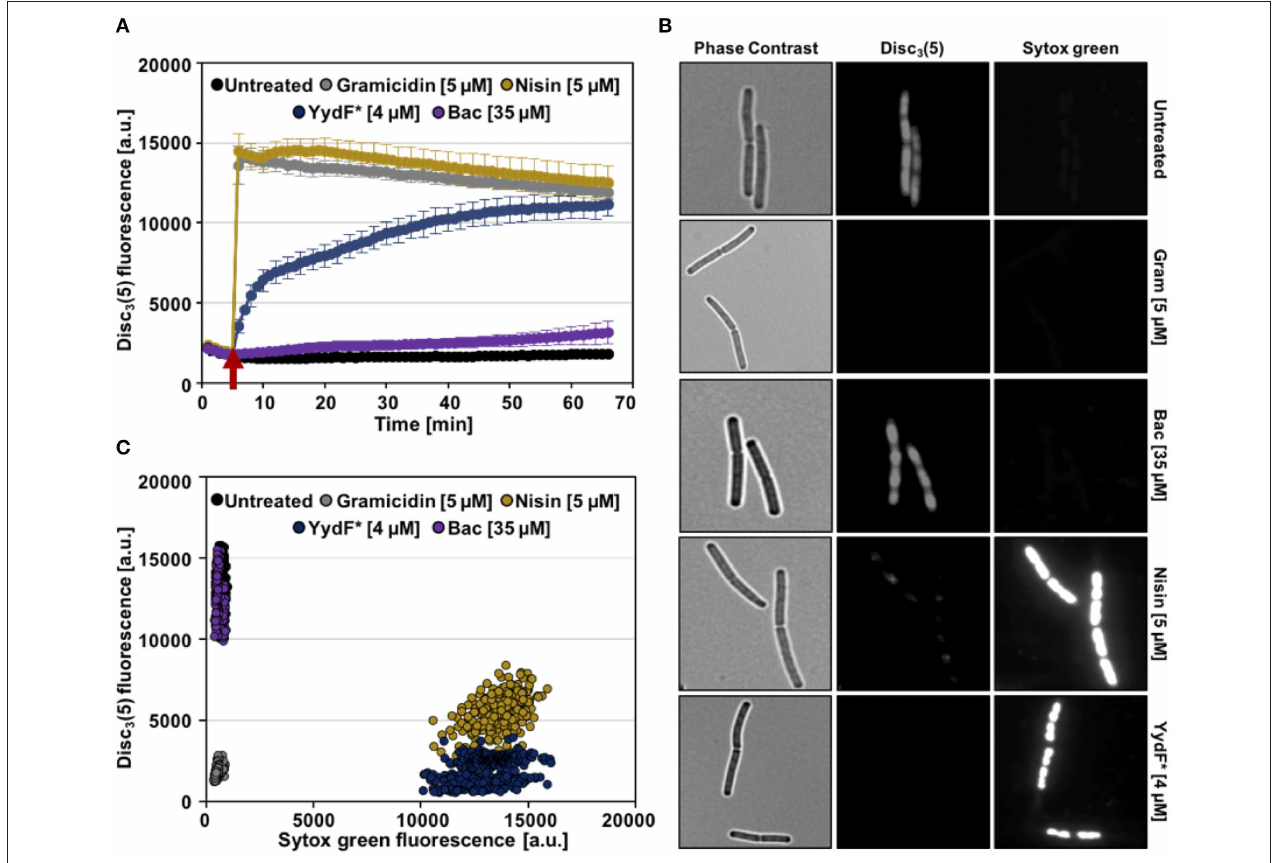
FIGURE 5 | YydF* causes membrane depolarization and membrane permeabilization. (A) Membrane potential levels of B. subtilis cells upon treatment with different antimicrobial compounds were obtained using the voltage sensitive dye DiSC 3 (5). Gramicidin (5 µ M, ∼ 10xMIC) and nisin ( ∼ MIC) (gray and gold lines) were used as positive controls for rapid and complete membrane depolarization. Addition of 4 µ M YydF* showed a rapid depolarization in the first 5min after addition, followed by a gradual complete depolarization. The peptide antibiotic bacitracin at 35 µ M and non-treated cells showed no membrane depolarization (purple and black lines). (B) Membrane potential and permeability measurements on single-cell level. Phase contrast (left panels) and fluorescence microscopy of B. subtilis cells stained with DiSC 3 (5) (middle panels) as well as with the membrane permeability indicator sytox Green (right panels). (C) Quantification of DiSC 3 (5) and sytox green fluorescence from individual cells per tested condition ( ∼ 300), derived from the fluorescence microscopy experiments in (B) . Membrane depolarization yields in low DiSC 3 (5) fluorescence, whereas membrane permeabilization results in high sytox green